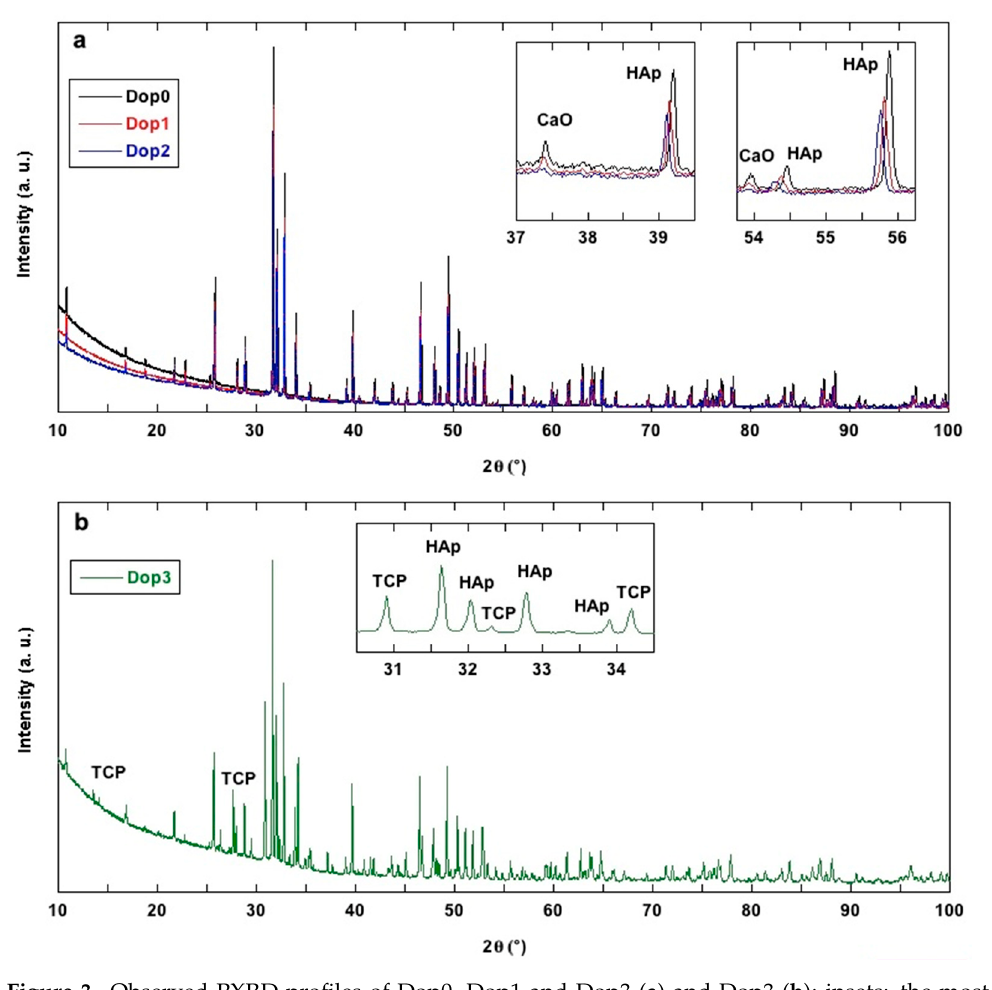
Figure 3. Observed PXRD profiles of Dop0, Dop1 and Dop3 ( a ) and Dop3 ( b ); insets: the most significant diffraction peaks corresponding to CaO (JCPDS, PDF-2, 00-078-0649) [36] ( a ) and β -TCP (JCPDS, PDF-2, 00-070-2065) [37,38], both compared with the closest HAp (JCPDS, PDF-2, 00-089- 6438) [35,39] peaks.